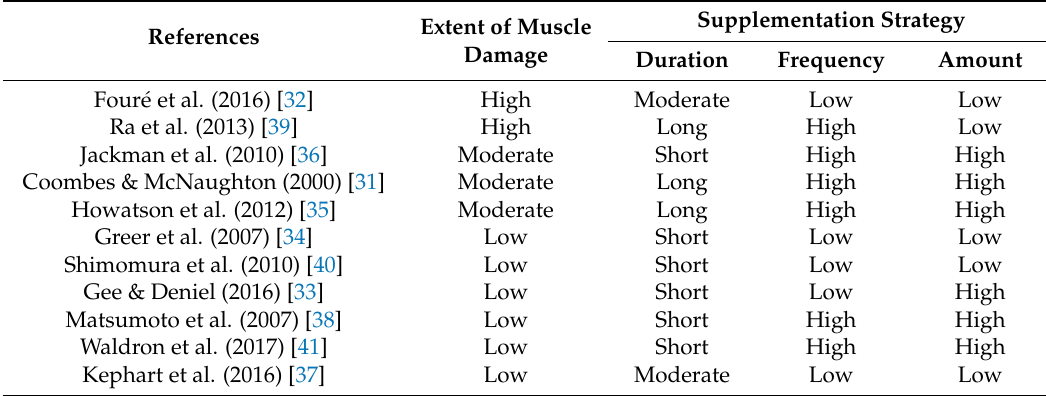
Table 4. Rating of supplementation strategy and extent of muscle